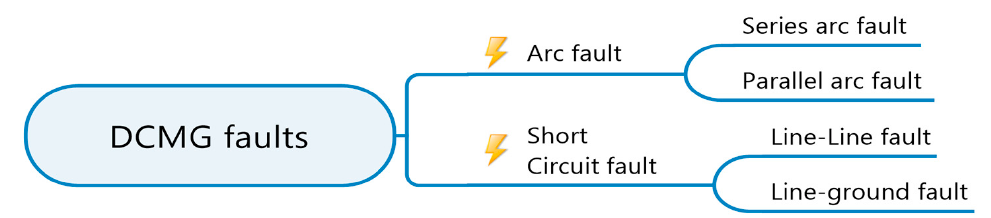
Figure 5. Classification of DCMGs faults [59].